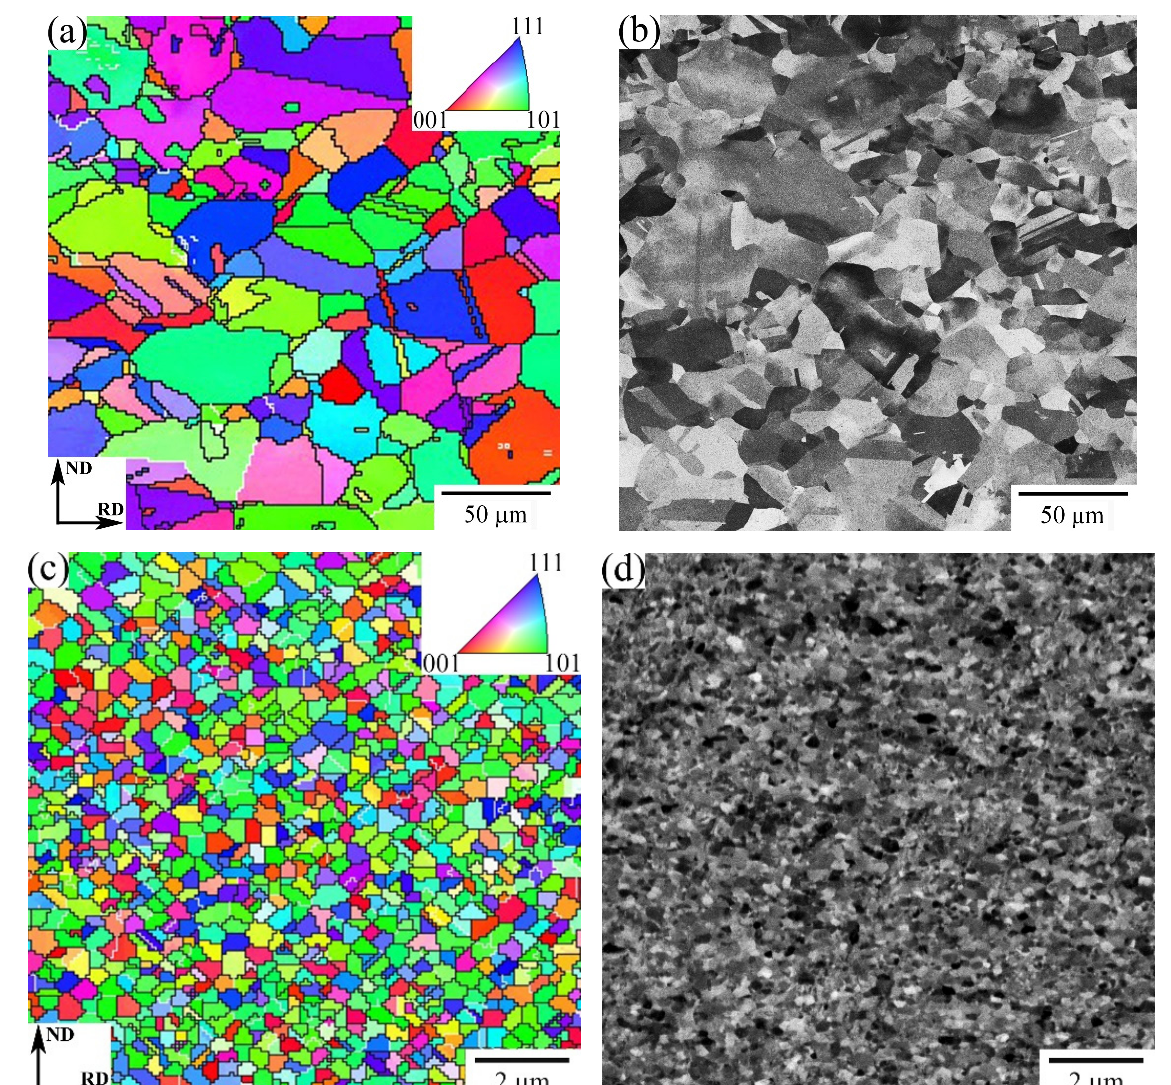
Figure 3. Crystal orientation maps ( a , c ) and electron backscatter diffraction (EBSD) images ( b , d ) of the coarse-grained nickel sheet ( a , b ) and of HPT-processed UFG nickel ( c , d ) before USW.